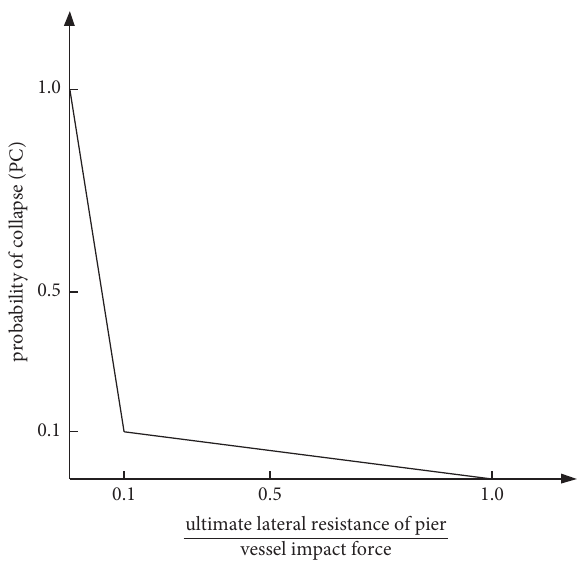
Figure 1: Probability of collapse